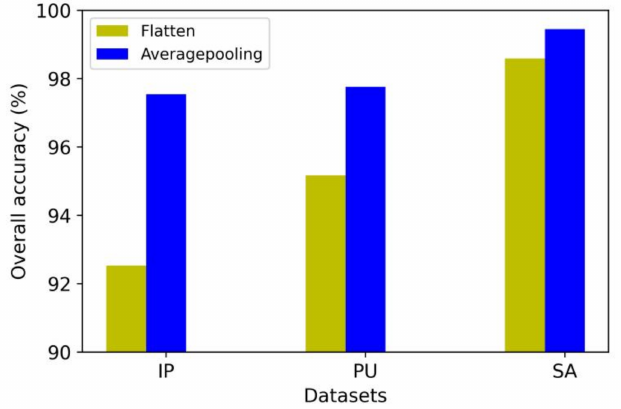
Figure 14. Comparison of AveragePooling and flatten.